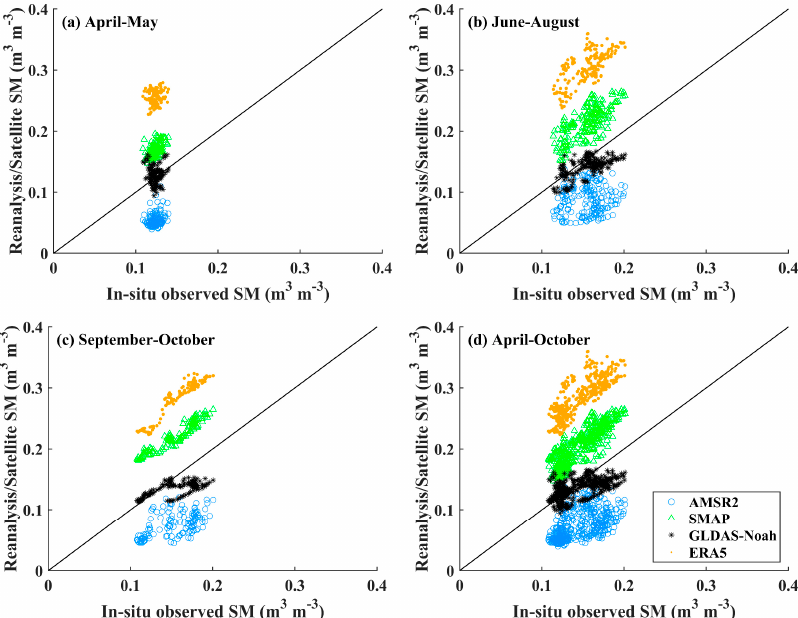
Figure 6. The comparison of the average for the extracted grids from AMSR2, SMAP, GLDAS-Noah, and ERA5 SM against the station-averaged in situ observed SM in the TP in different seasons during non-frozen period from 2015 to 2016.